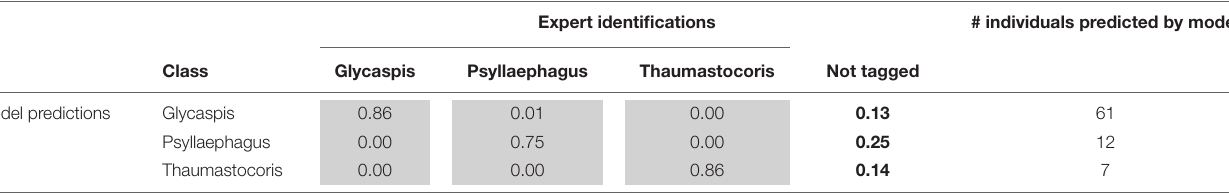
The model’s confidence threshold was set to 0.7. The gray-shaded area denotes the three focal insects, boldfaced proportions are false positive errors.